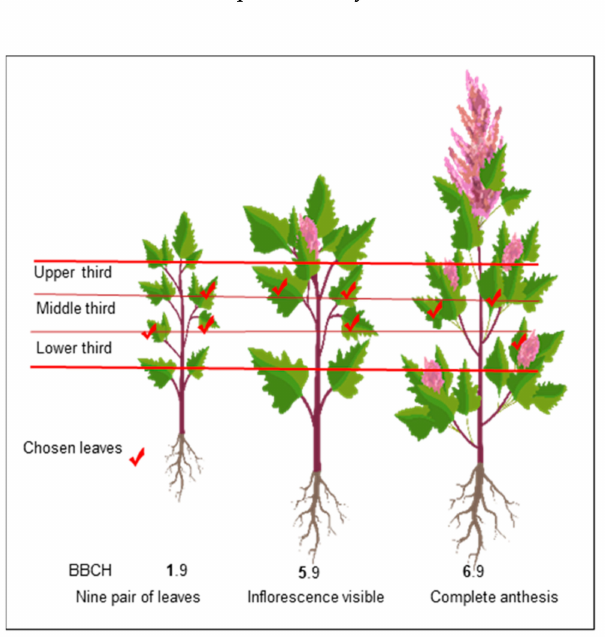
Figure 8. Modified from Danielsen and Munk (2004) [97]. Three-leaf field assessment method for quinoa-downy mildew at different growth